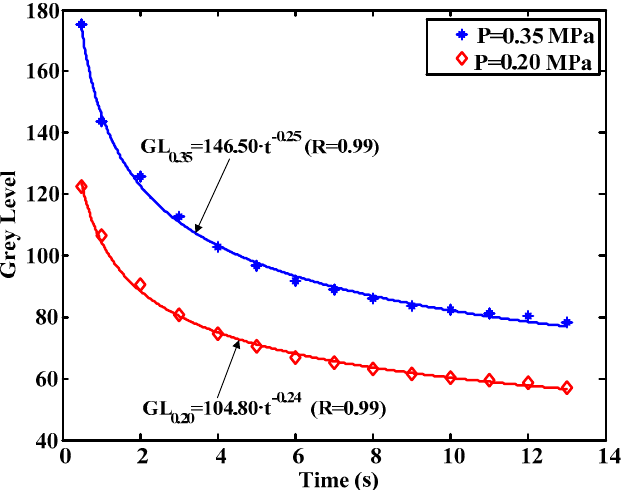
Figure 10. Grey levels during the unload phase.